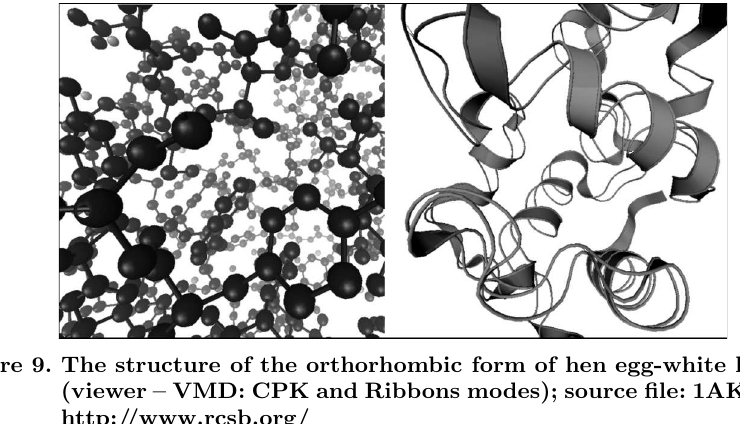
Figure 9. The structure of the orthorhombic form of hen egg-white lysozyme (viewer – VMD: CPK and Ribbons modes); source file: 1AKI.PDB – http://www.rcsb.org/